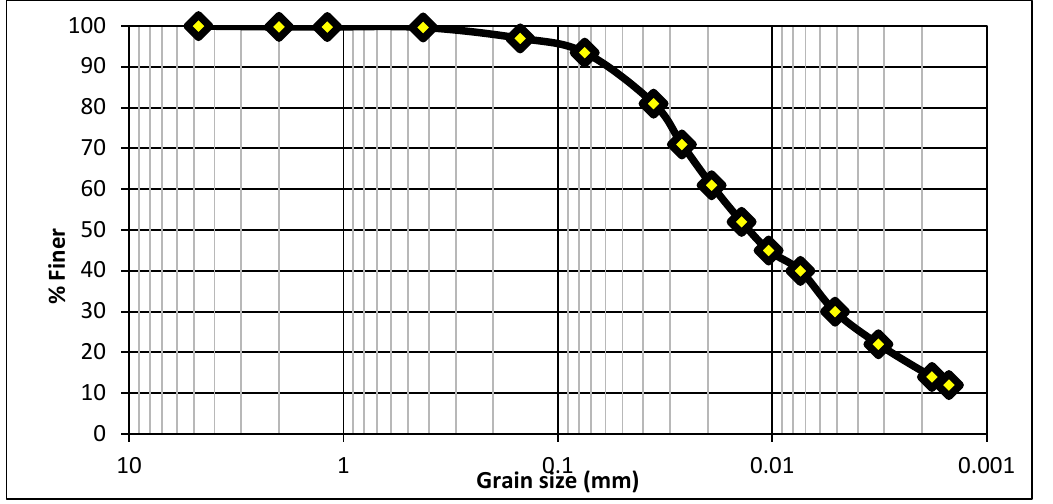
Figure 3. Particle size distribution curve.